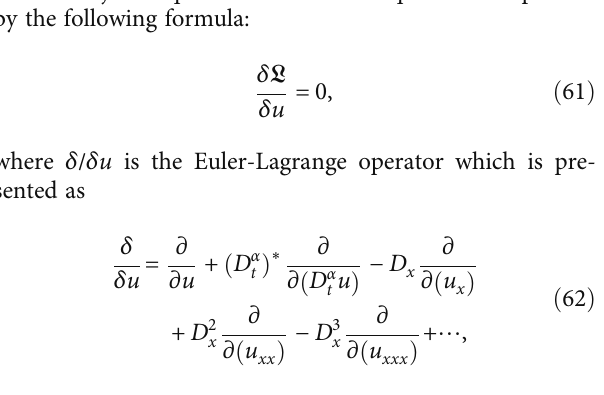
ð x , t Þ of Equation (1) for K 2